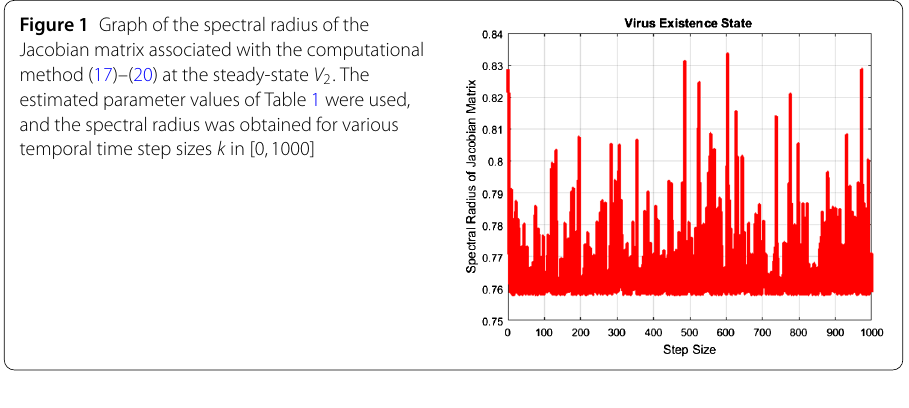
Figure 1 Graph of the spectral radius of the Jacobian matrix associated with the computational method (17)–(20) at the steady-state V 2 . The estimated parameter values of Table 1 were used, and the spectral radius was obtained for various temporal time step sizes k in